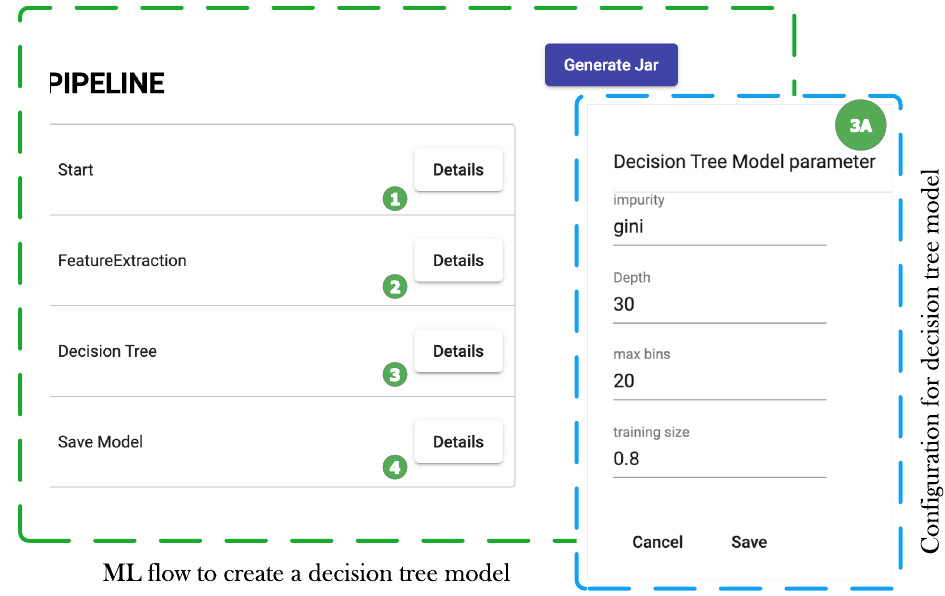
Figure 7. Graphical flow to create a decision tree model for forest cover